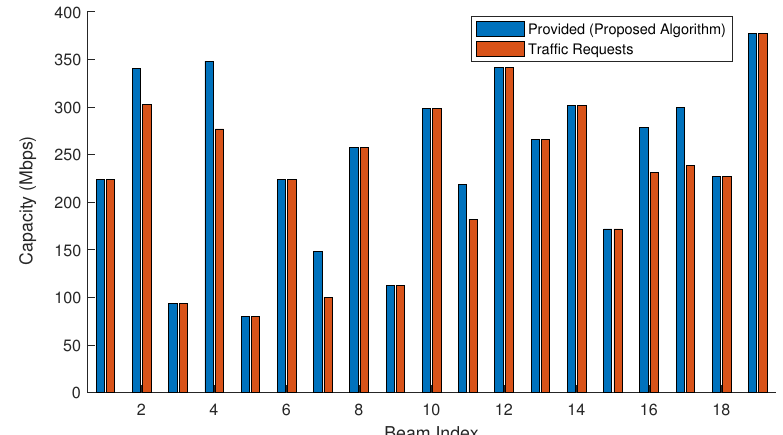
Figure 6. Provided capacity of the proposed MGBA-SPA scheme of each ground